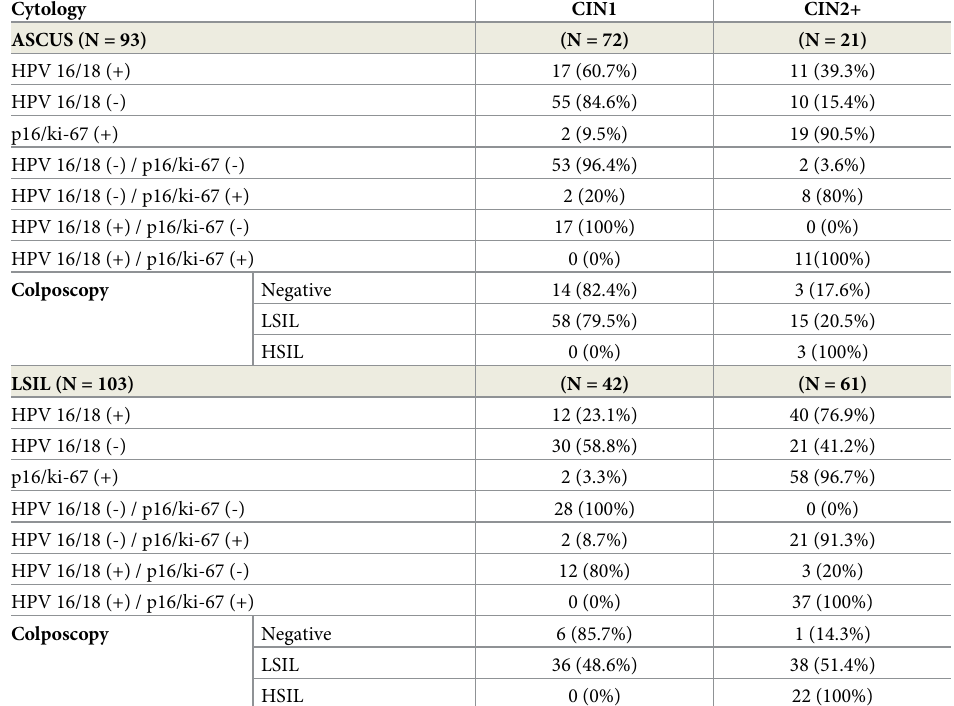
Table 4. Correlation of HPV 16/18, p16/ki-67, colposcopy and combination of HPV 16/18/ p16/ki-67 with biopsy results in our population study. Cytology CIN1 CIN2+